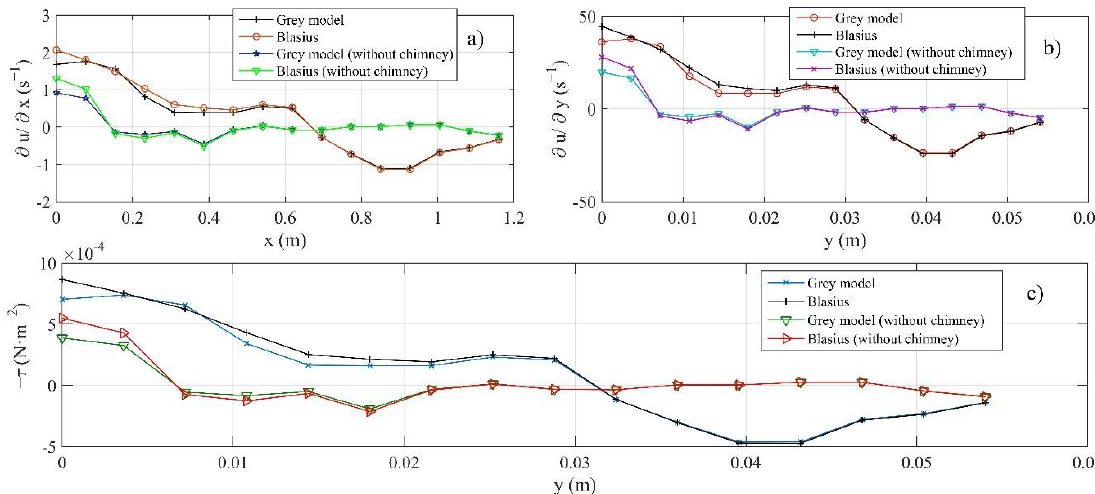
Figure 8. The change in velocity gradients and shear stress with coordinate space ( a ) The gradient of the horizontal component ( u ) of the local velocity, ( b ) Shear rate of air in a solar collector, ( c ) The change in the shear stress (τ) along the transverse direction ( y )